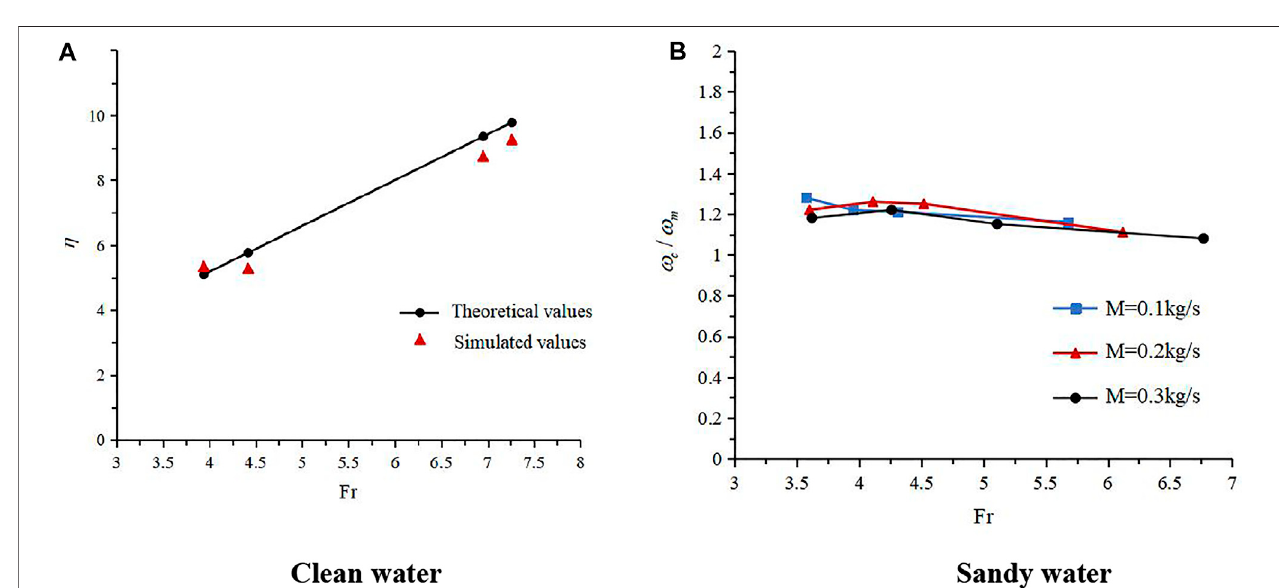
FIGURE 4 | Model validation with (A) clean water and (B) sandy